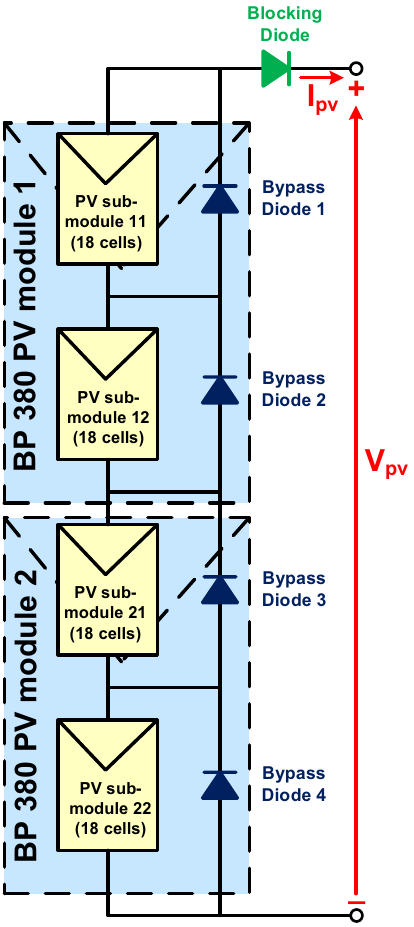
Figure 1. PV array configuration using two BP 380 PV modules serially connected.